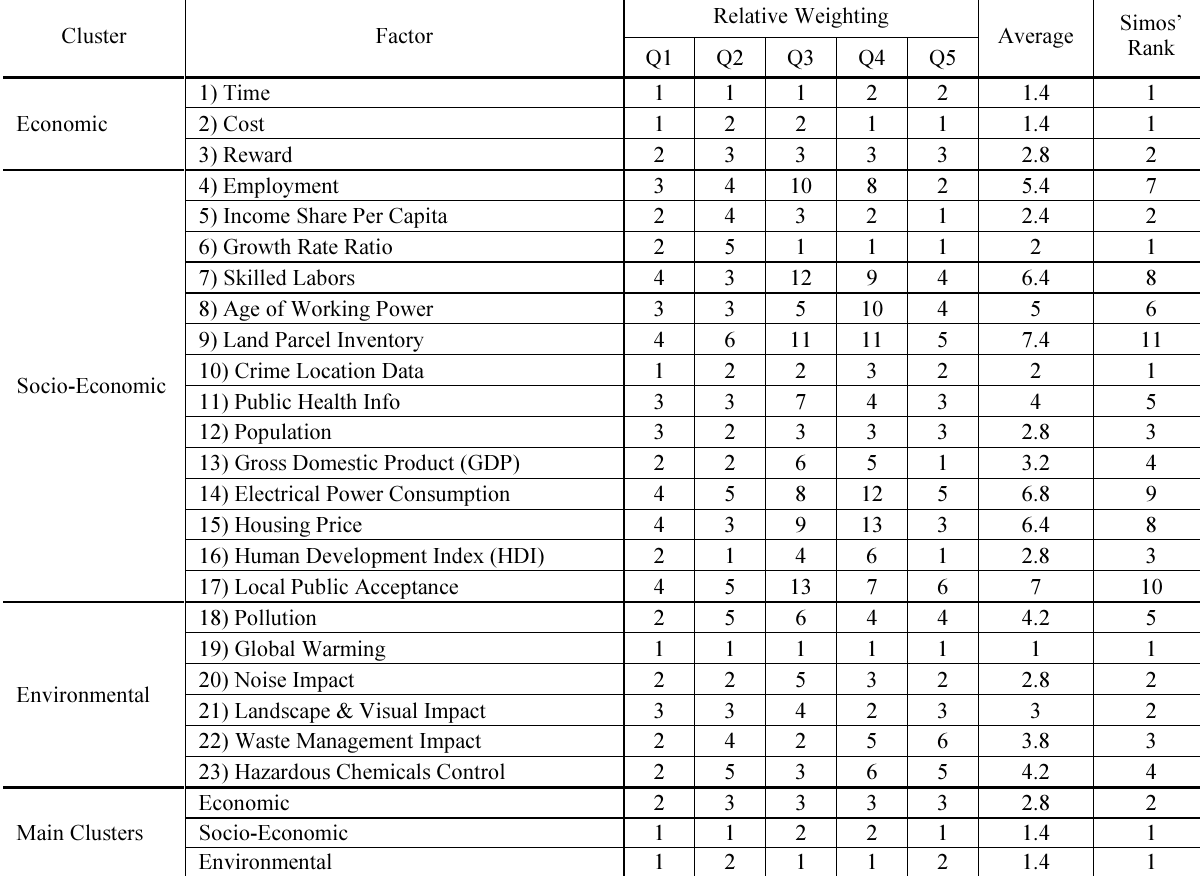
Relative Weighting